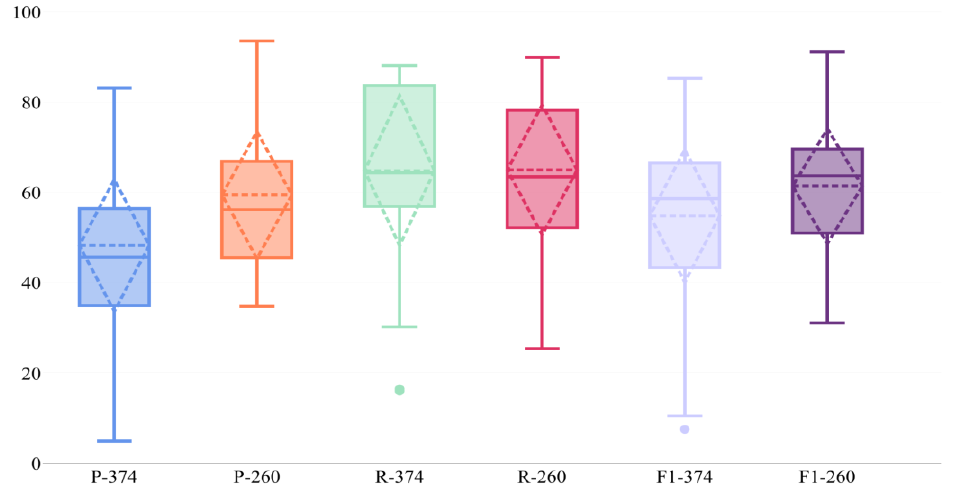
Figure 7. Statistical description of how our proposed method learns the meanings of concepts accurately and in a balanced manner. Precision and recall are denoted by the letters P and R, respectively, and the following number denotes the number of concepts utilized in the experiment.